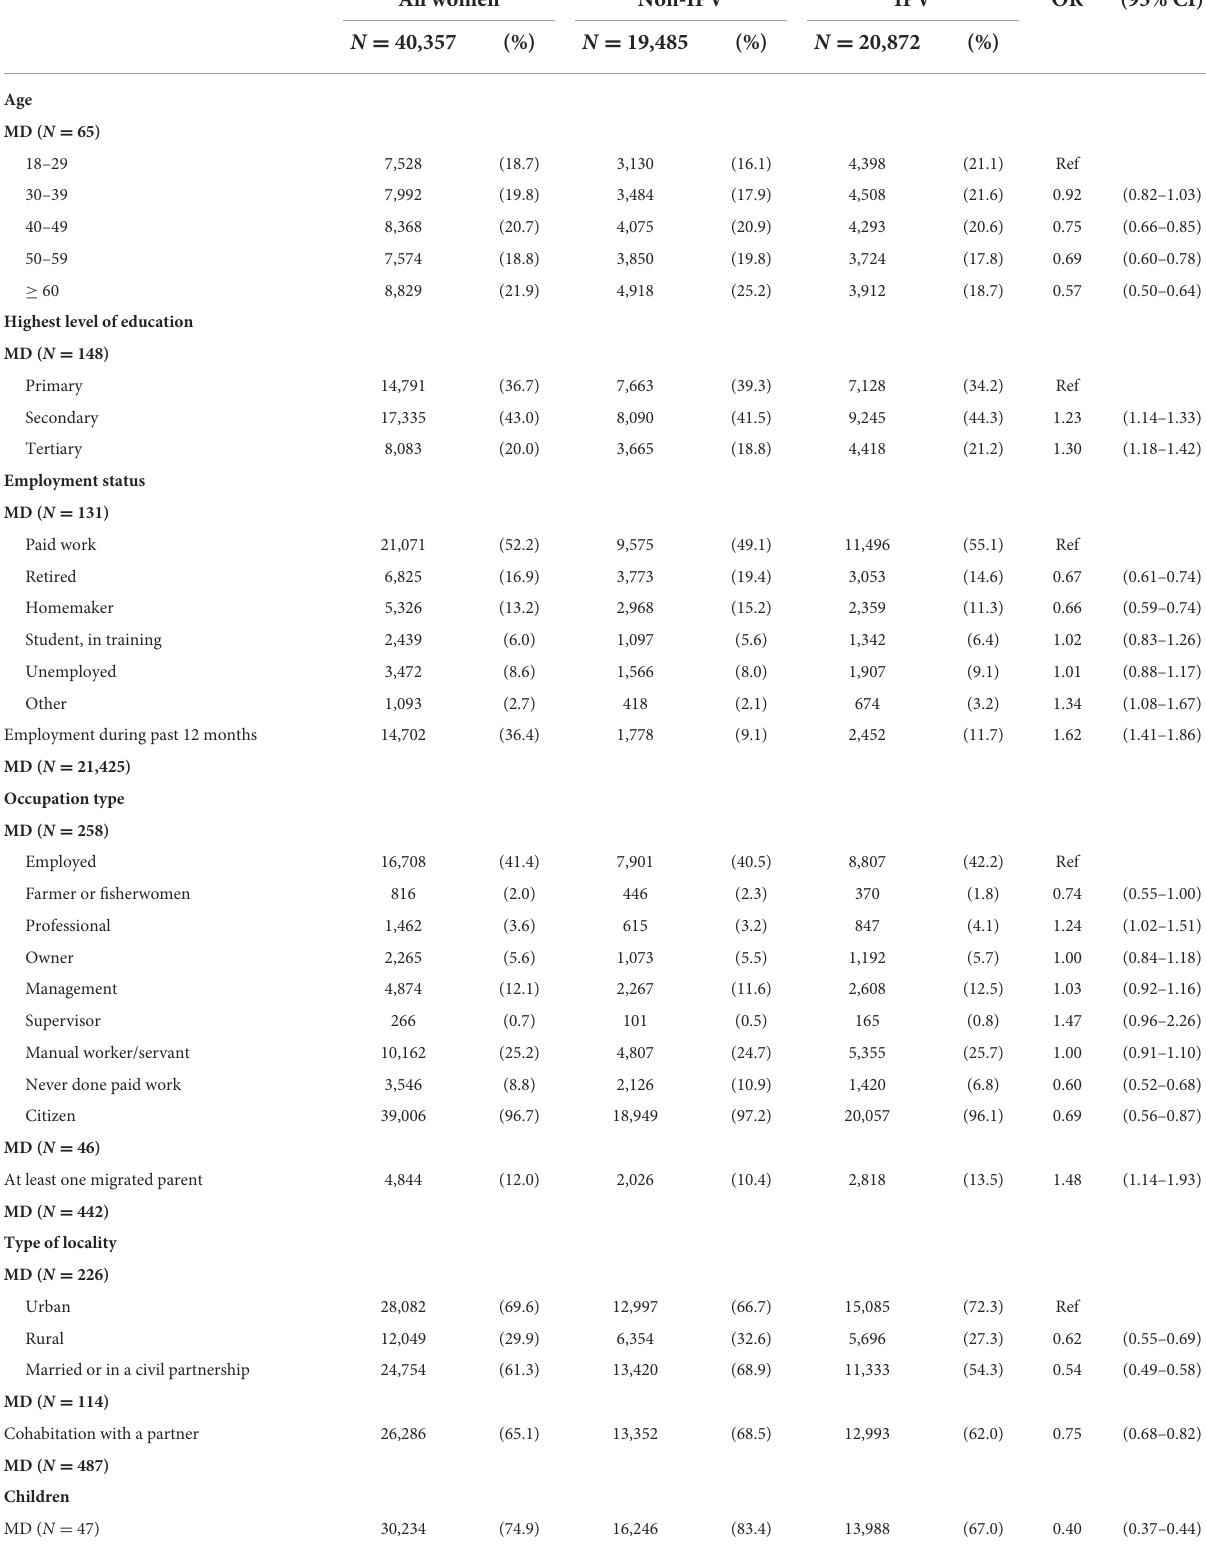
TABLE 1 General characteristics of ever-partnered whole population and victims and non-victims of intimate partner